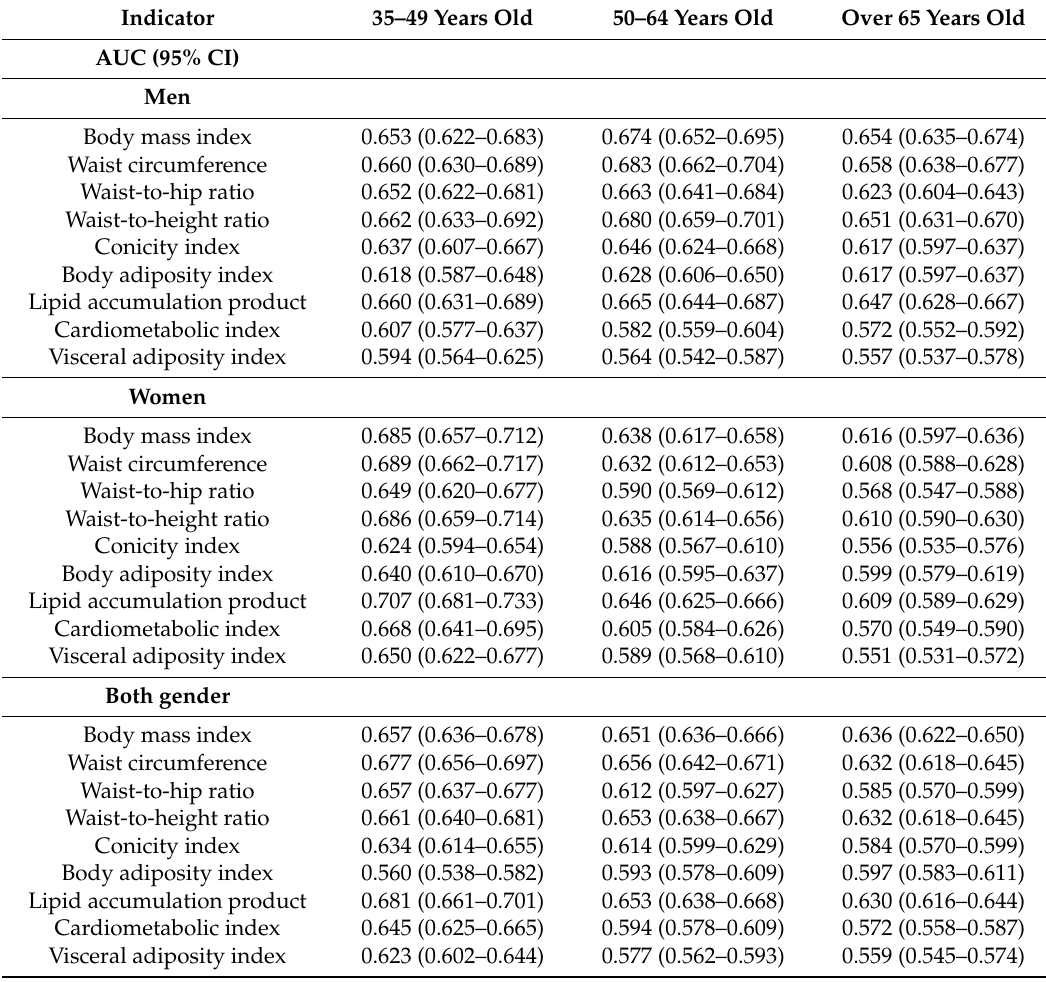
Table A1. Area under curve (AUC), cut-off point and diagnostic performance of various anthropometric and adiposity indices with hypertension classified by age and